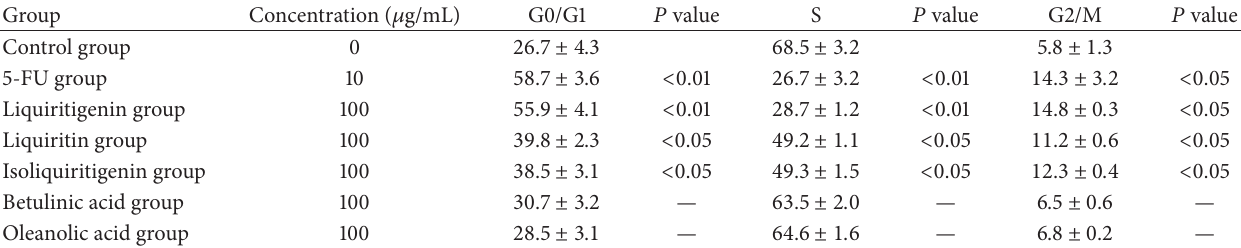
Table 2: Effects of various drugs on cell cycle phases of primary hepatoma cells ( 𝑥 ± 𝑠 ,